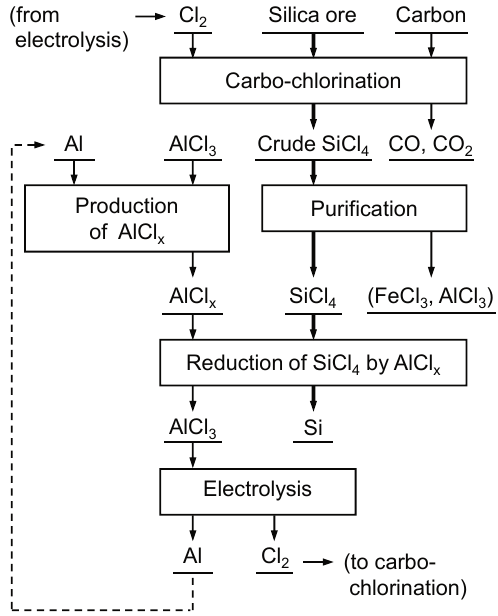
Figure 1. Flowchart of the polycrystalline silicon produc- tion process based on reduction by aluminum subchlo- rides.